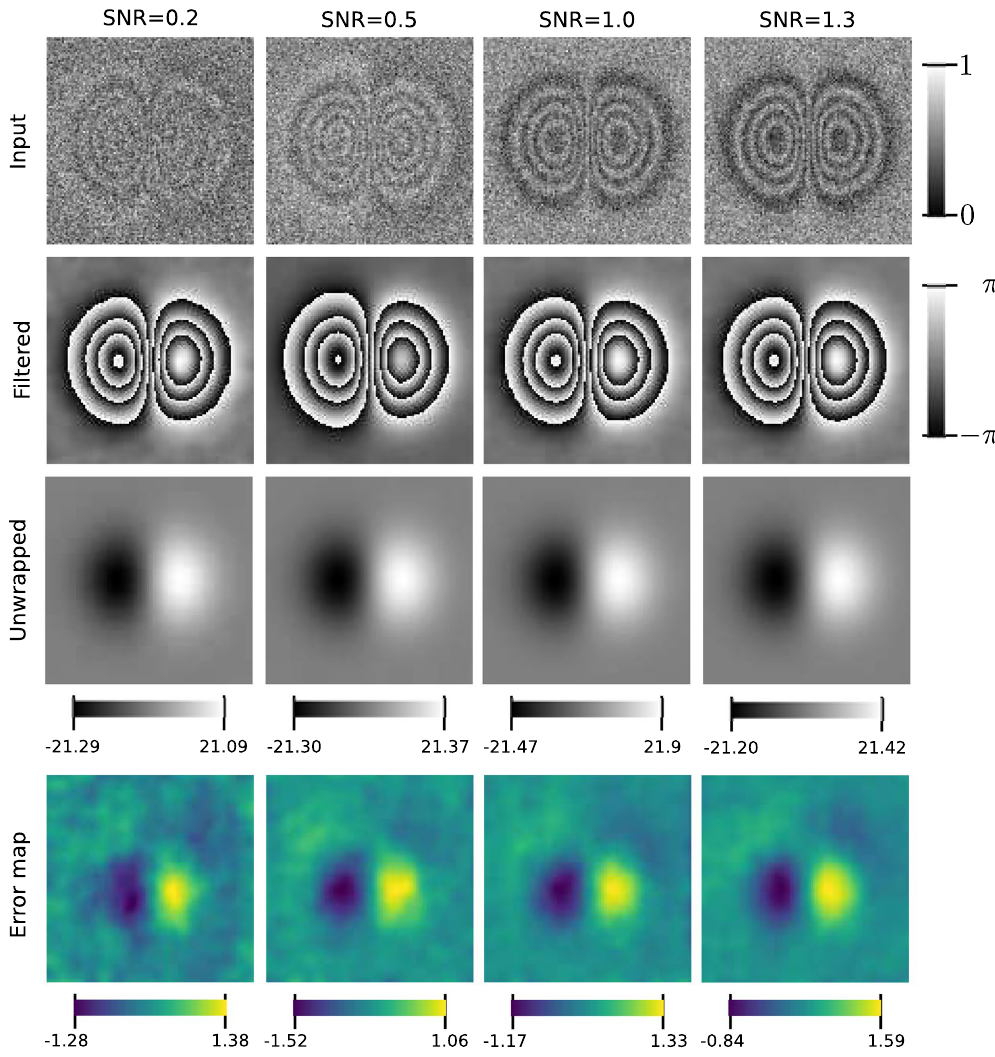
Figure 4. Test with four different levels of noise. The image columns show the test for SNR = 0.2, 0.5, 1.0 and 1.3 as depicted. The rows show the noisy fringe pattern, the obtained filtered phase, unwrapped phase and the error map. The color bars indicate the dynamic range of the images. The error map is the error (in radians) we obtain for each pixel by taking the difference of the obtained unwrapped phase and the ground true